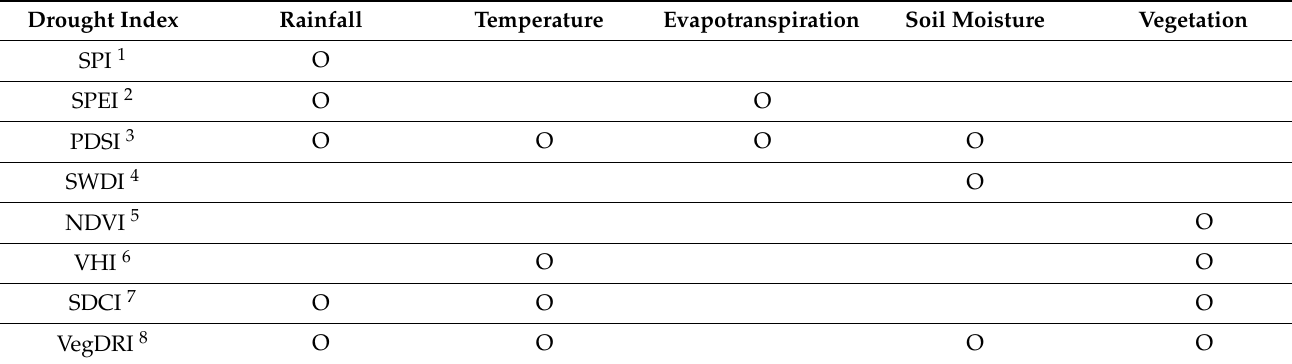
Table 1. Major meteorological and agricultural factors that make up the drought